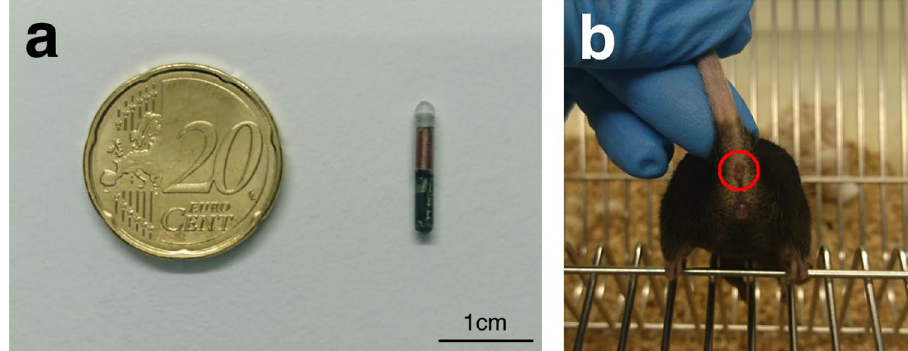
Figure 5. Illustration of the measurement modalities used to obtain core and surface temperature data. ( a ) Size comparison of a temperature transponder to a 20-cent coin. ( b ) Mouse with the ano-genital area exposed. Red circle depicts perianal region used as the site for surface temperature